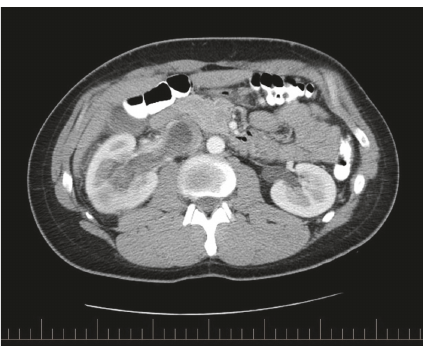
Figure 3: Cystic and biphasic tumor with benign, spindle cell stroma, focally resembling ovarian stroma, arranged with increased density in pericystic areas. Epithelial lining of cystic spaces is composed of a monolayer with cuboidal, flattened, and, focally, a hobnail appearance. No morphologic features of dysplasia are identified. Hematoxylin and eosin original magnification: 300x.